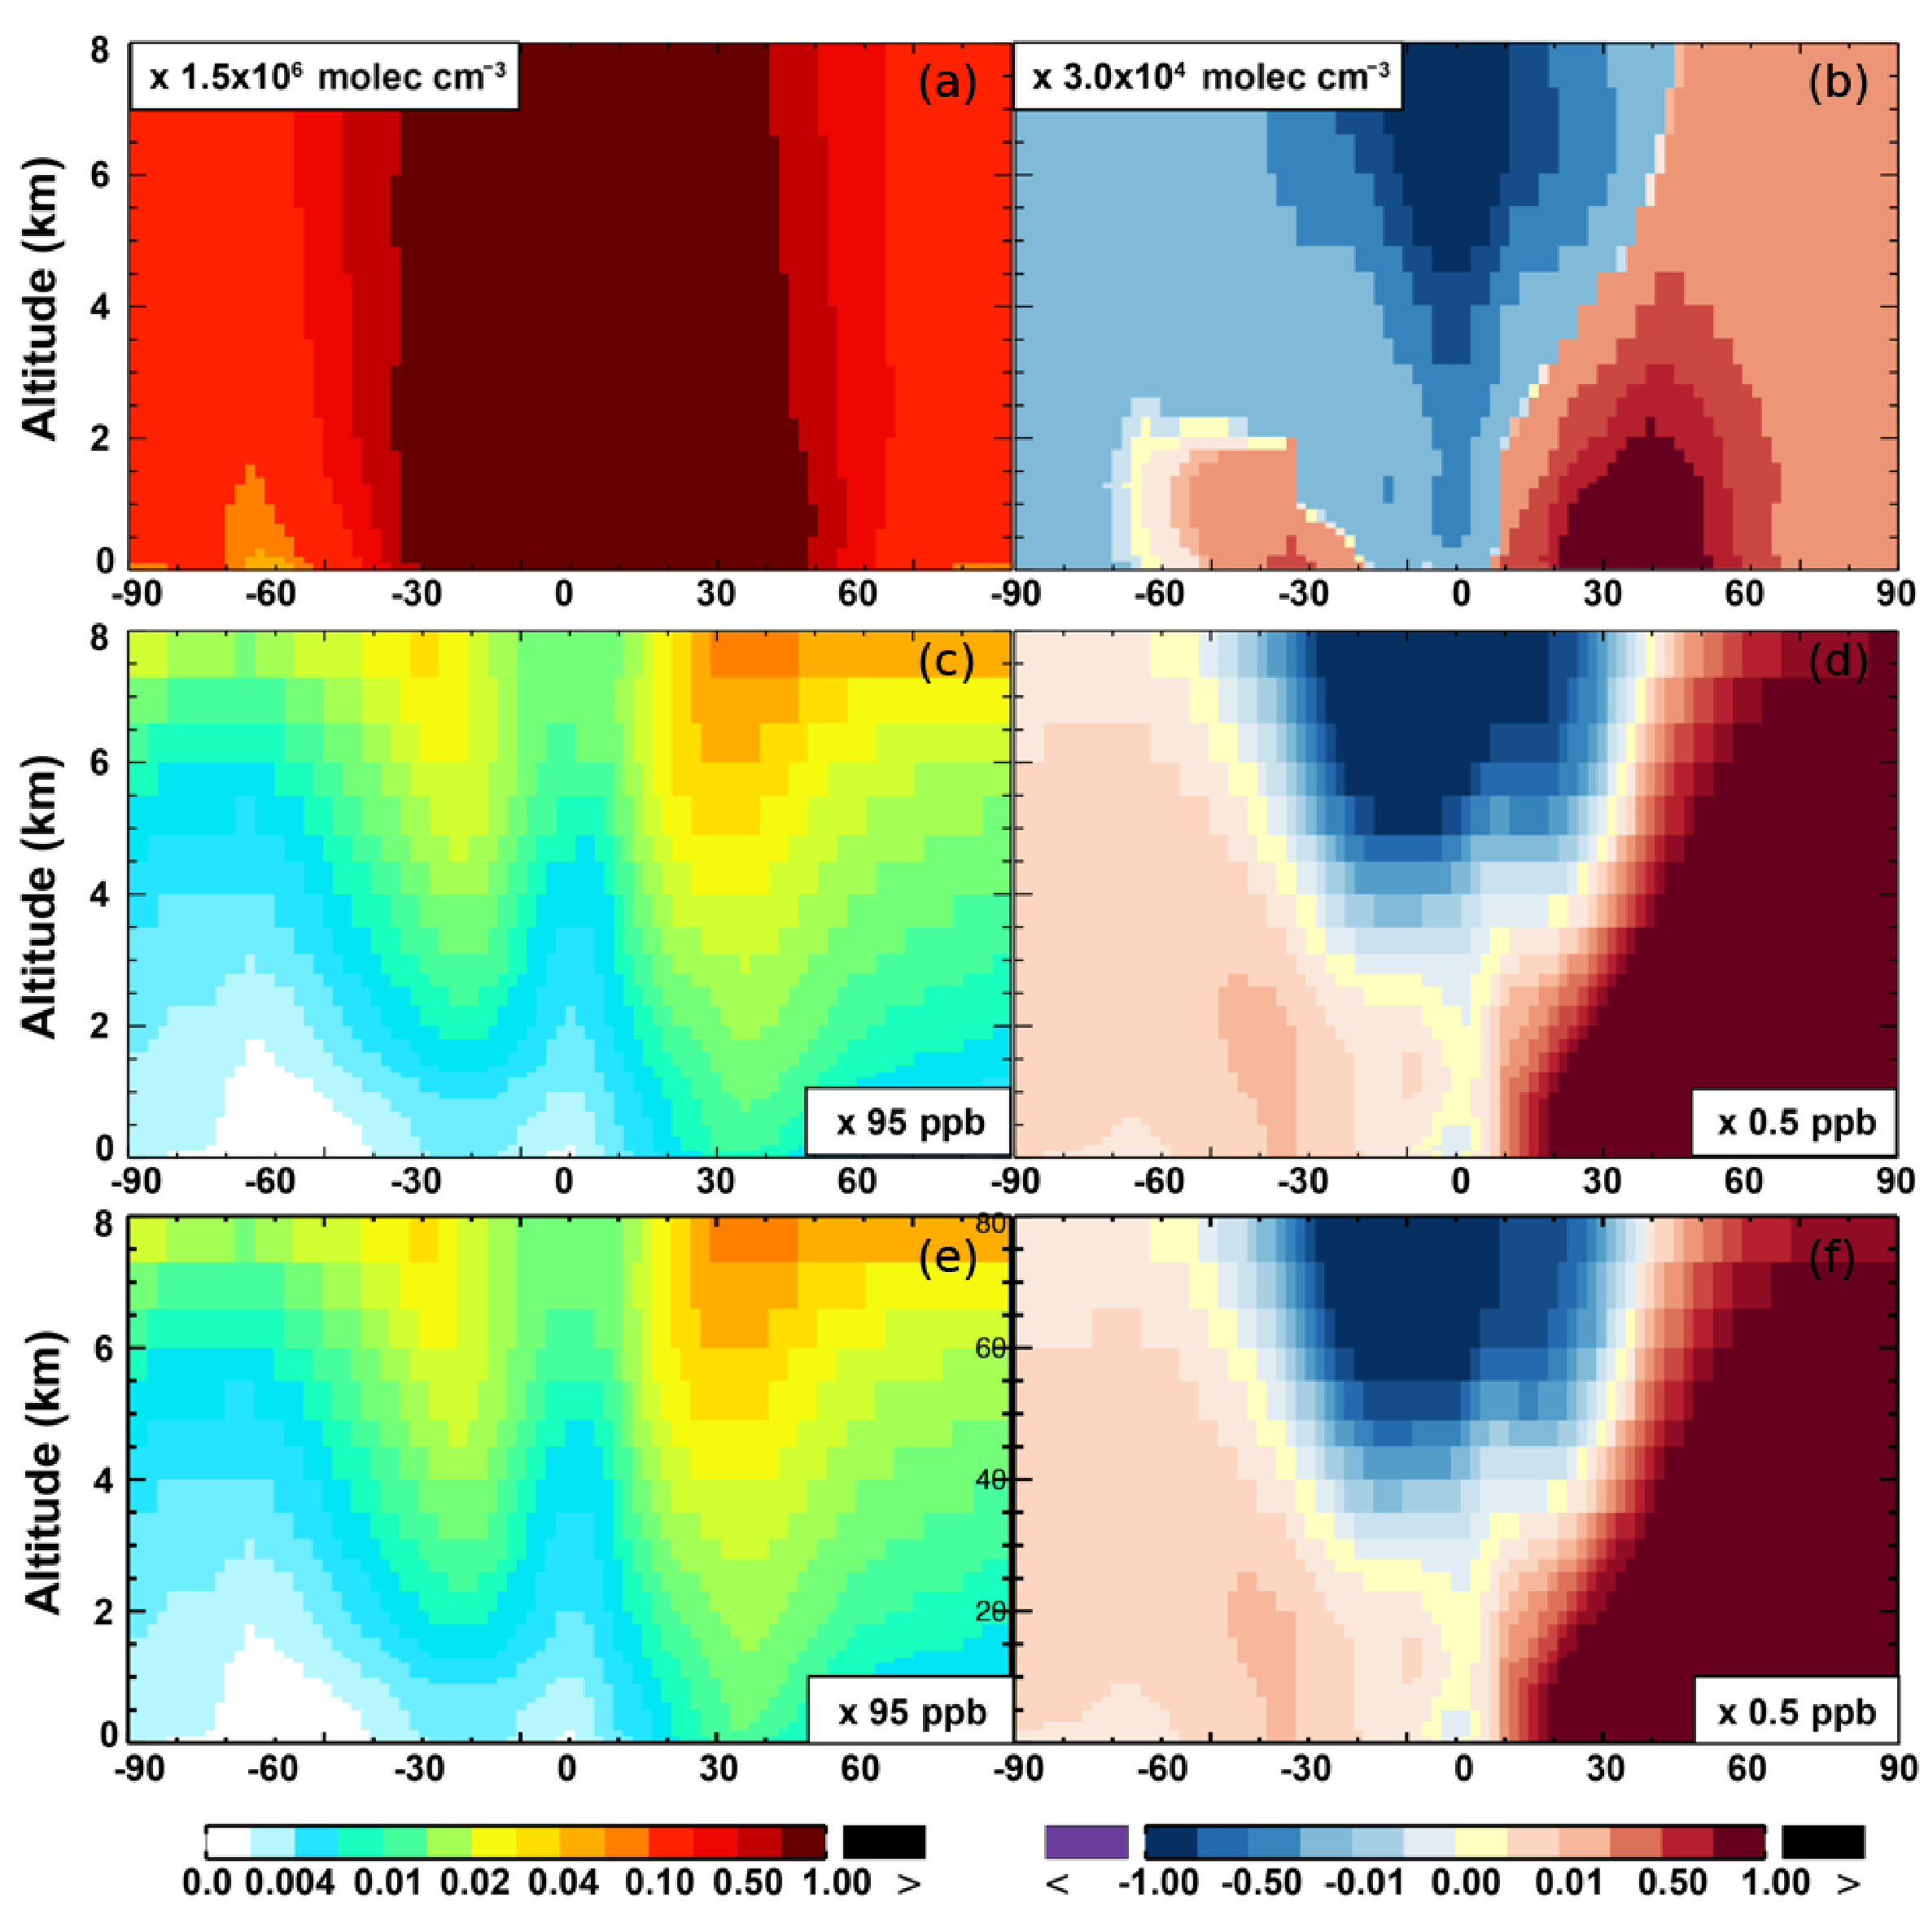
Same as Fig. 7 but for OH (a, b), O3
(c, d), and Ox
(e, f).